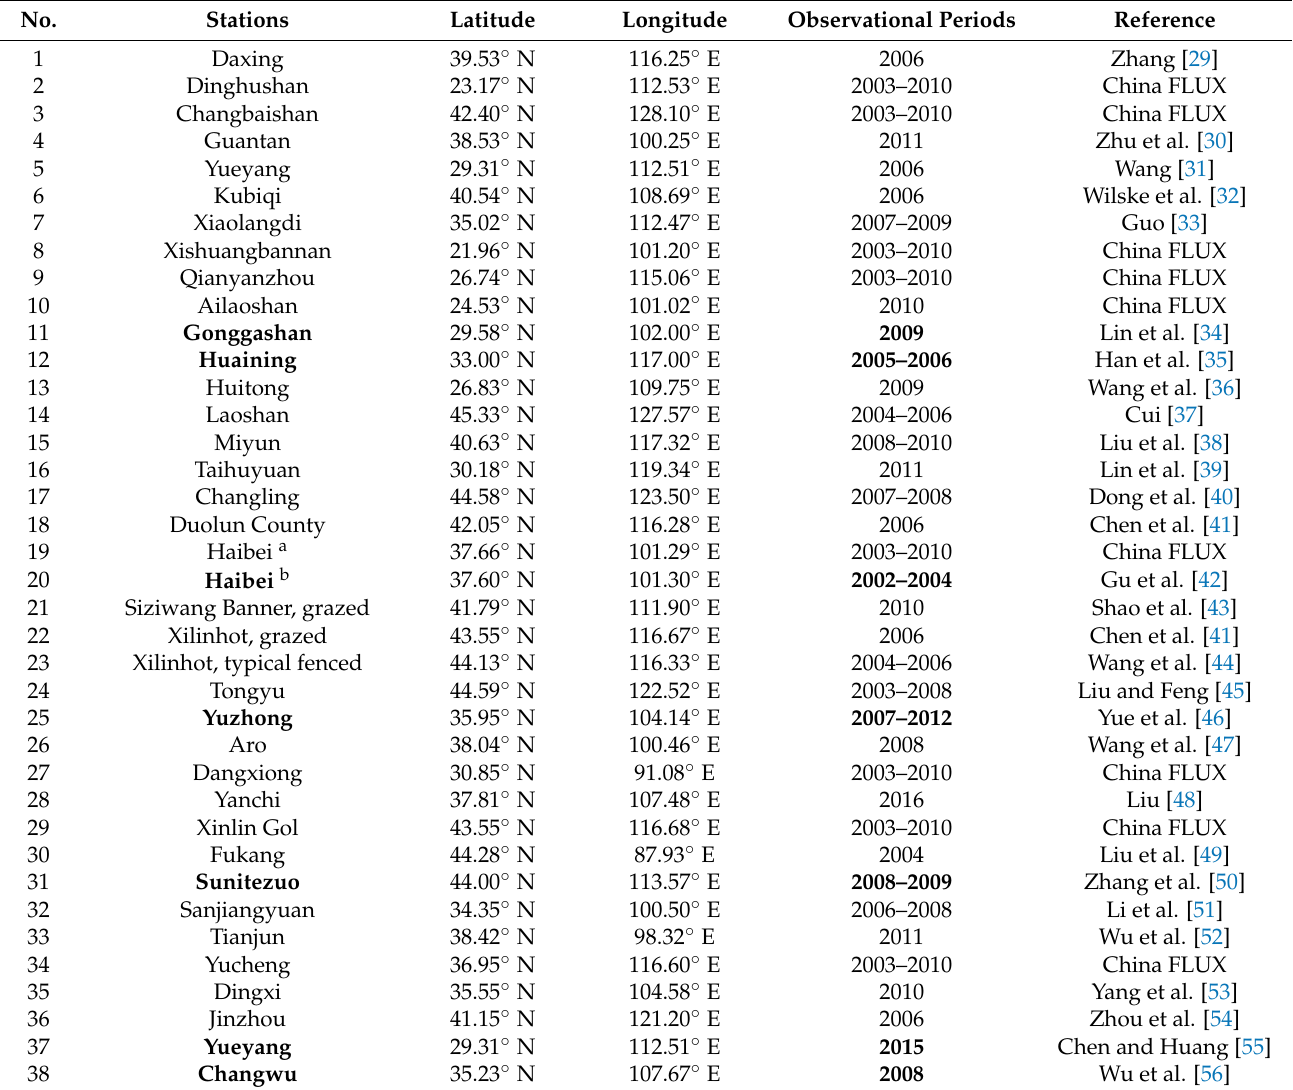
Table 1. Metadata for each flux station including station name, location, altitude, years of available data, and